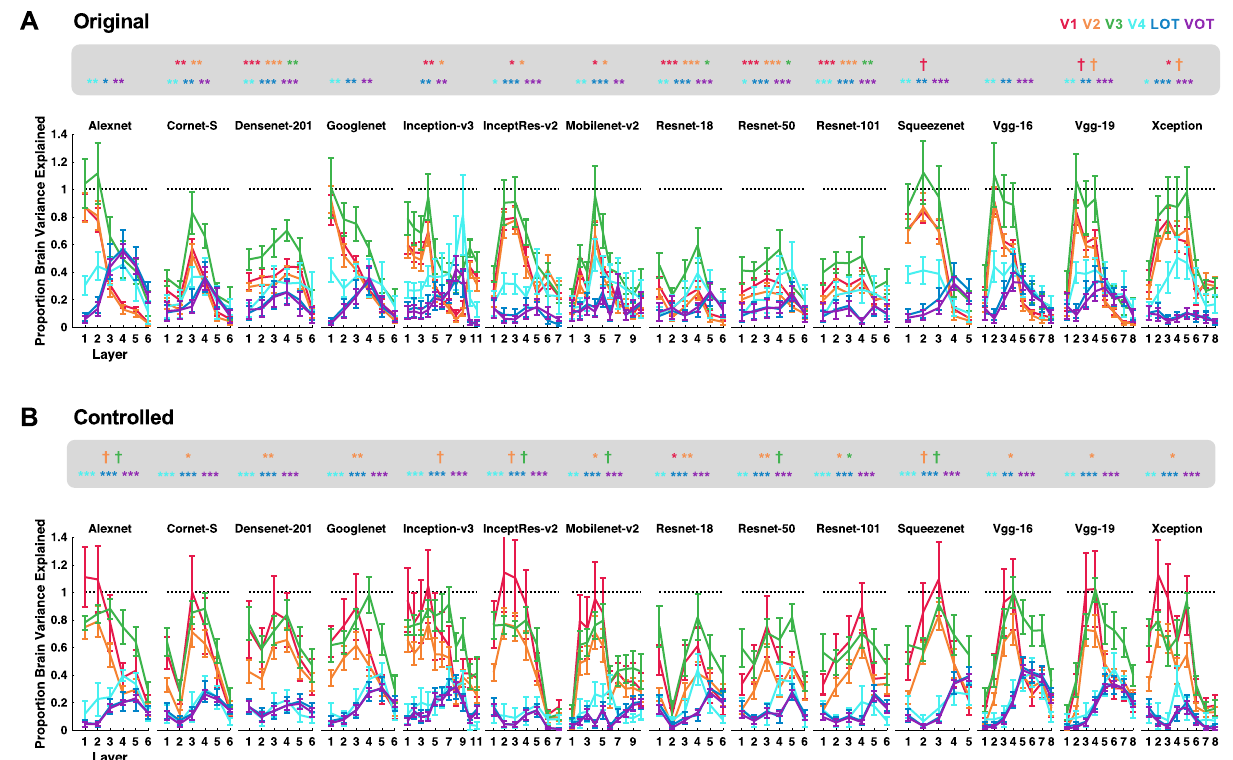
Fig. 3 Quantifying the proportion of explainable brain RDM variance captured by each sampled CNN layer in Experiment 1 for the processing of images from real-world object categories. A Results for the Original images. B Results for the Controlled images. N = 6 human participants. The asterisks at the top of each plot mark the signi fi cance level of the difference between 1 and the highest proportion of variance explained by a CNN for each brain region; one-tailed t -tests were used as only values below 1 were meaningful here; all p values reported were corrected for multiple comparisons for the six brain regions included using the Benjamini – Hochberg procedure. Error bars indicate standard errors of the means. † p < 0.1, * p < 0.05, ** p < 0.01, *** p < 0.001. Source data are provided as a Source Data fi